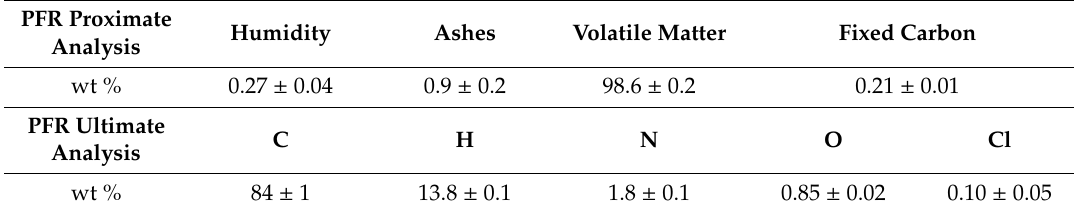
Table 6. PFR proximate and ultimate analyses